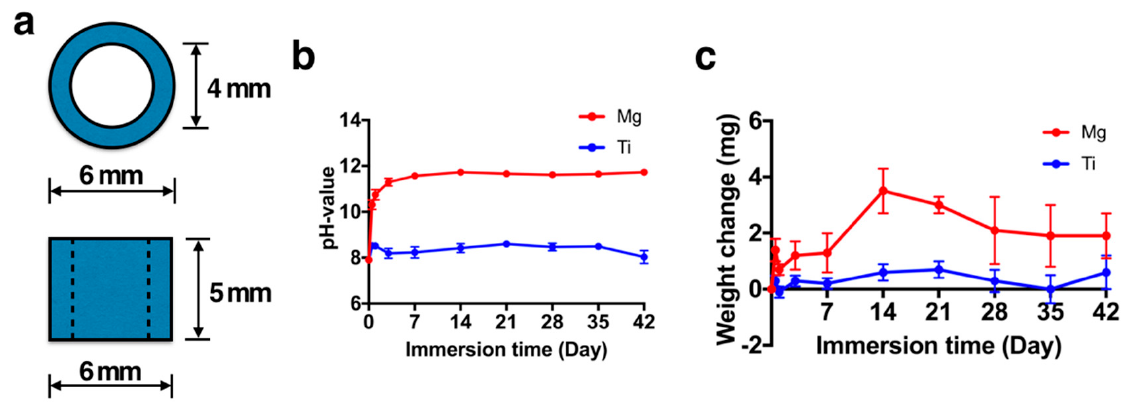
Figure 4. Degradation behavior of the pure magnesium ring: ( a ) dimensions of the metal ring, ( b ) weight change of the pure magnesium ring, and ( c ) pH change of Hank’s solution. (N = 5 per group) .